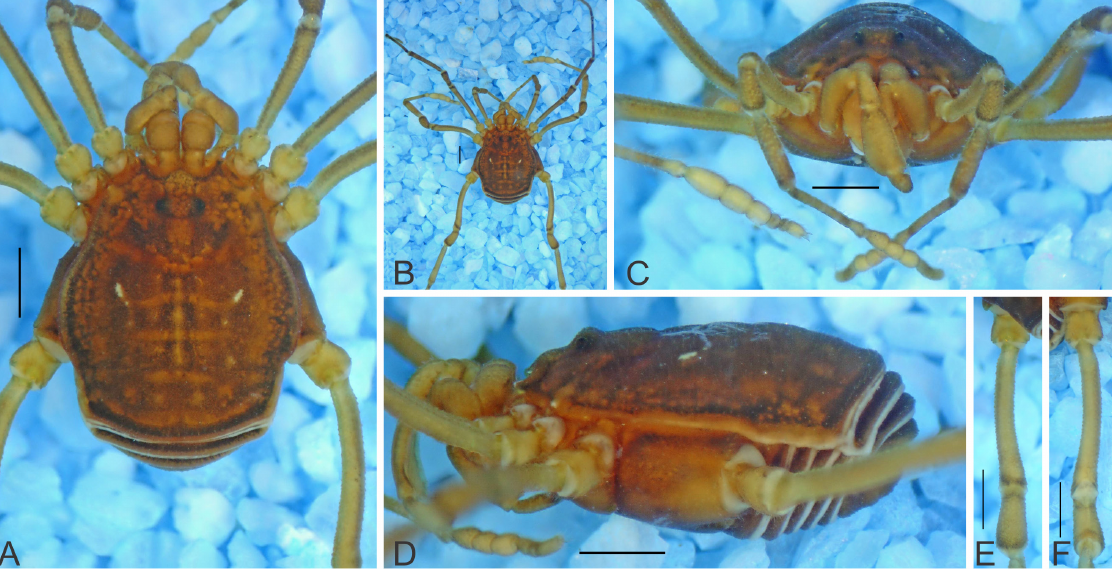
Fig. 11. Libitia iguaque sp. nov., ♂ (MNRJ 19765), habitus. A . Dorsal view. B . Dorsal view, panoramic. C . Frontal view. D . Lateral right view. E–F . Right femur IV, dorsal and ventral view, respectively. Scale bars = 1